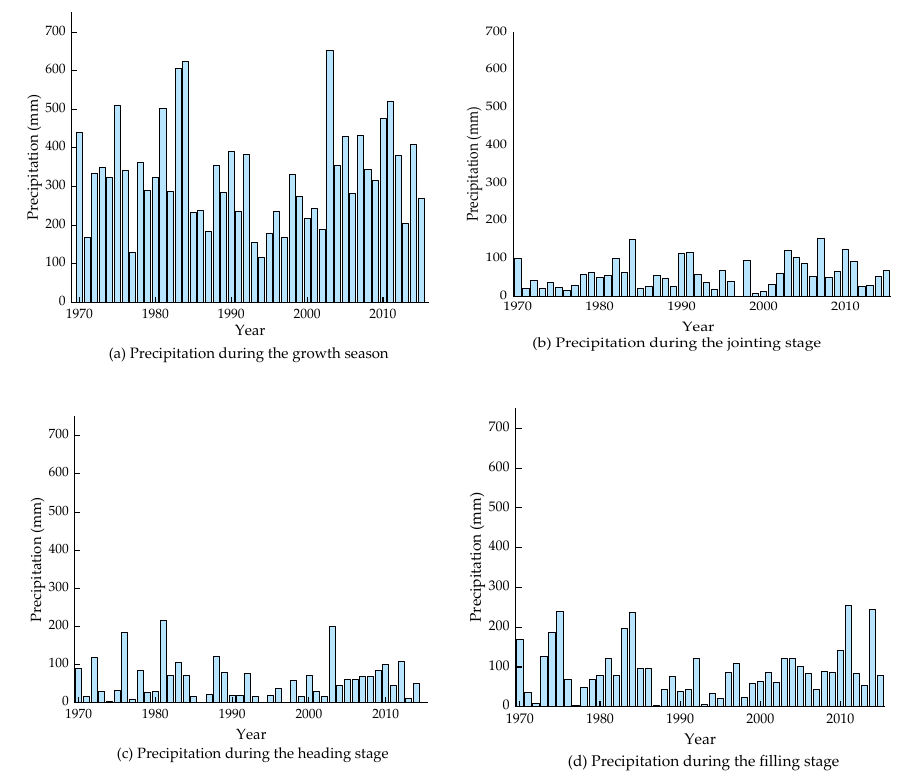
Figure 6. E ff ective precipitation during di ff erent growth stages of summer maize from 1970 to 2015 at Figure 6. Effective precipitation during different growth stages of summer maize from 1970 to 2015 Wugong at Wugong County.